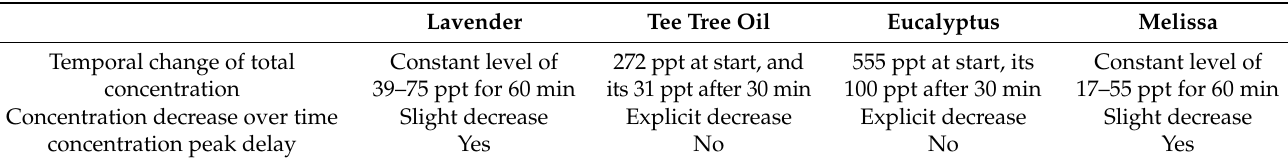
Table 7. Summary of GC/MS analyses to each diffused essential